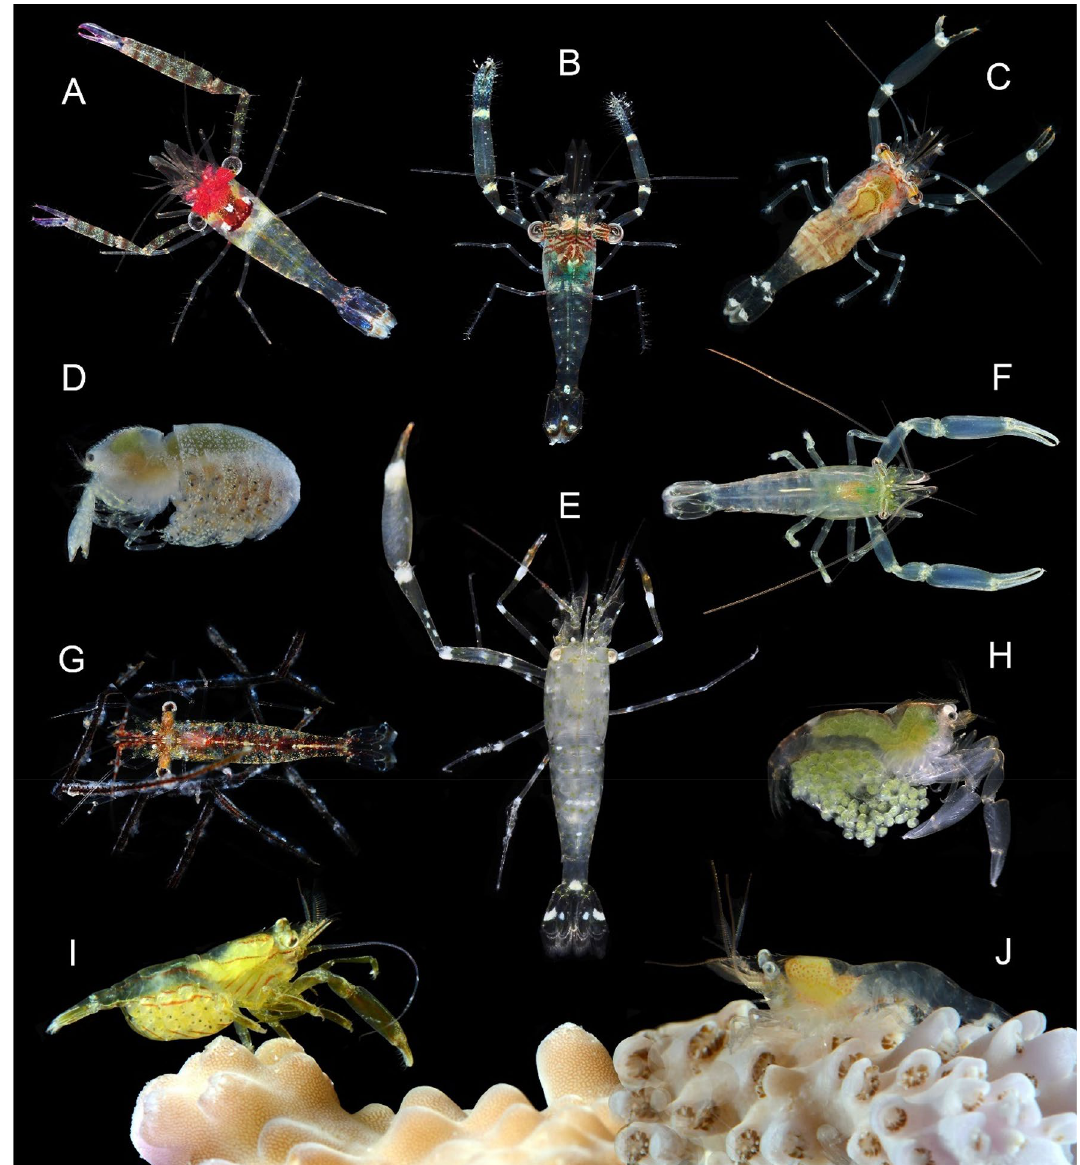
Figure 1. Photographs of symbiotic palaemonid shrimp. ( A ) Exoclimenella maldivensis ; ( B ) Periclimenella spinifera ; ( C ) Cuapetes amymone ; ( D ) Anapontonia denticauda ; ( E ) Palaemonella aliska ; ( F ) Harpilius lutescens ; ( G ) Cuapetes nilandensis ; ( H ) Ischnopontonia lophos ; ( I ) Philarius imperialis ; ( J ) Vir orientalis . Author of photographs: Zdeněk